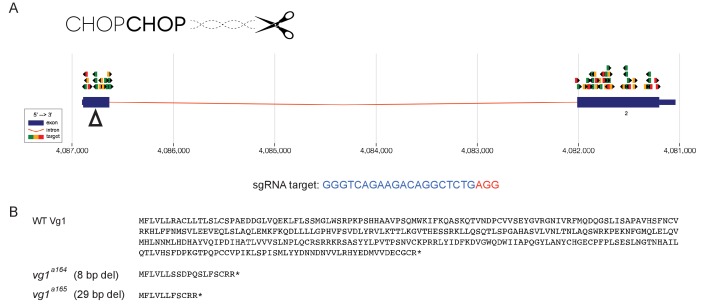
vg1 mutant alleles.(A) Single guide RNAs (sgRNAs) targeting the vg1/dvr1/gdf3 gene were designed using CHOPCHOP (Labun et al., 2016; Montague et al., 2014). Colored arrows indicate possible sgRNA targets, color-coded according to predicted efficiency (green: good to red: bad). Open arrowhead indicates the location of the sgRNA used in this study. The sgRNA sequence is provided in blue, with the PAM motif in red. (B) 8 bp (vg1a164) and 29 bp (vg1a165) deletion alleles cause frameshifts in Vg1, truncating it from a 355 amino acid protein to predicted 18 and 11 amino acid peptides, respectively.